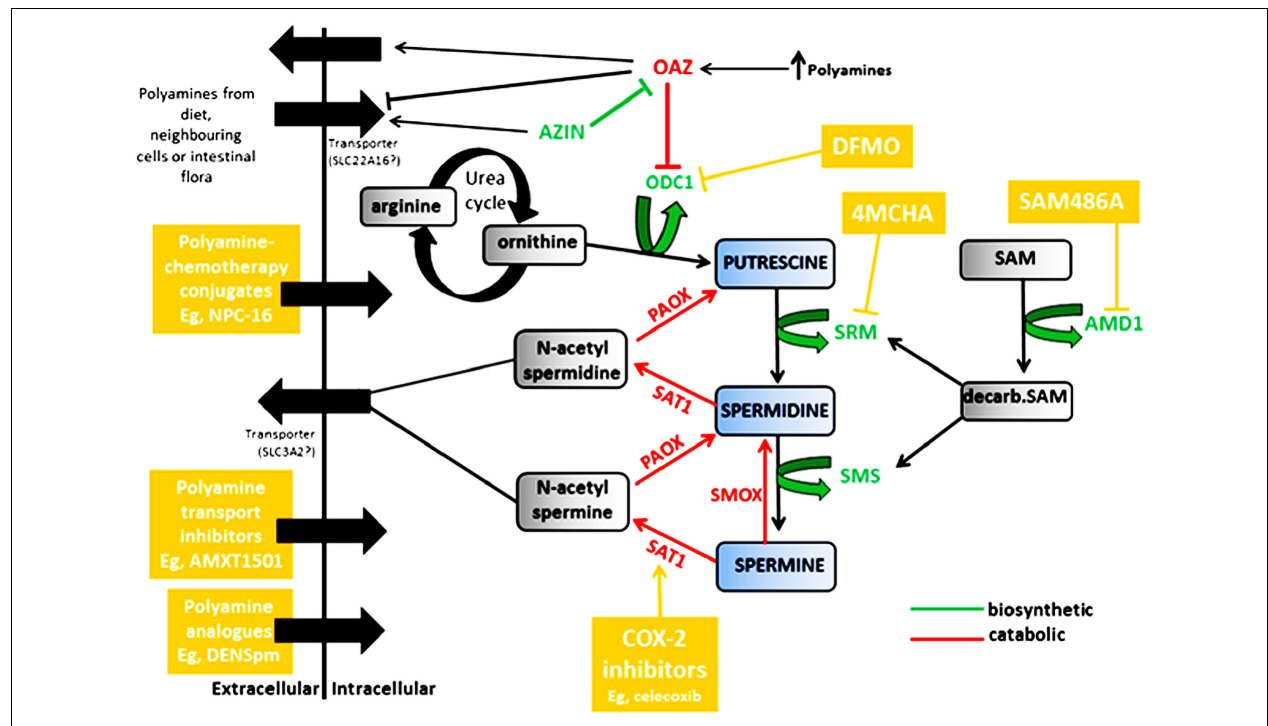
FIGURE 1 | Regulation of the polyamines putrescine, spermidine and spermine by biosynthetic enzymes (shown in green) and catabolic enzymes (shown in red). Compounds and classes of compounds that target various aspects of polyamine regulation are shown in yellow. ODC1, ornithine